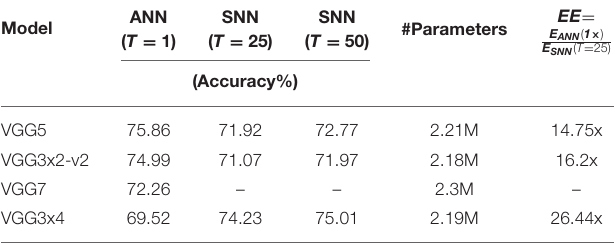
TABLE 8 | Accuracy, Total, # parameters, and Energy Efficiency EE for AGD trained SNN topologies (refer Table 9 ) of latency T = 25,50, and corresponding ANN on CIFAR10 data.